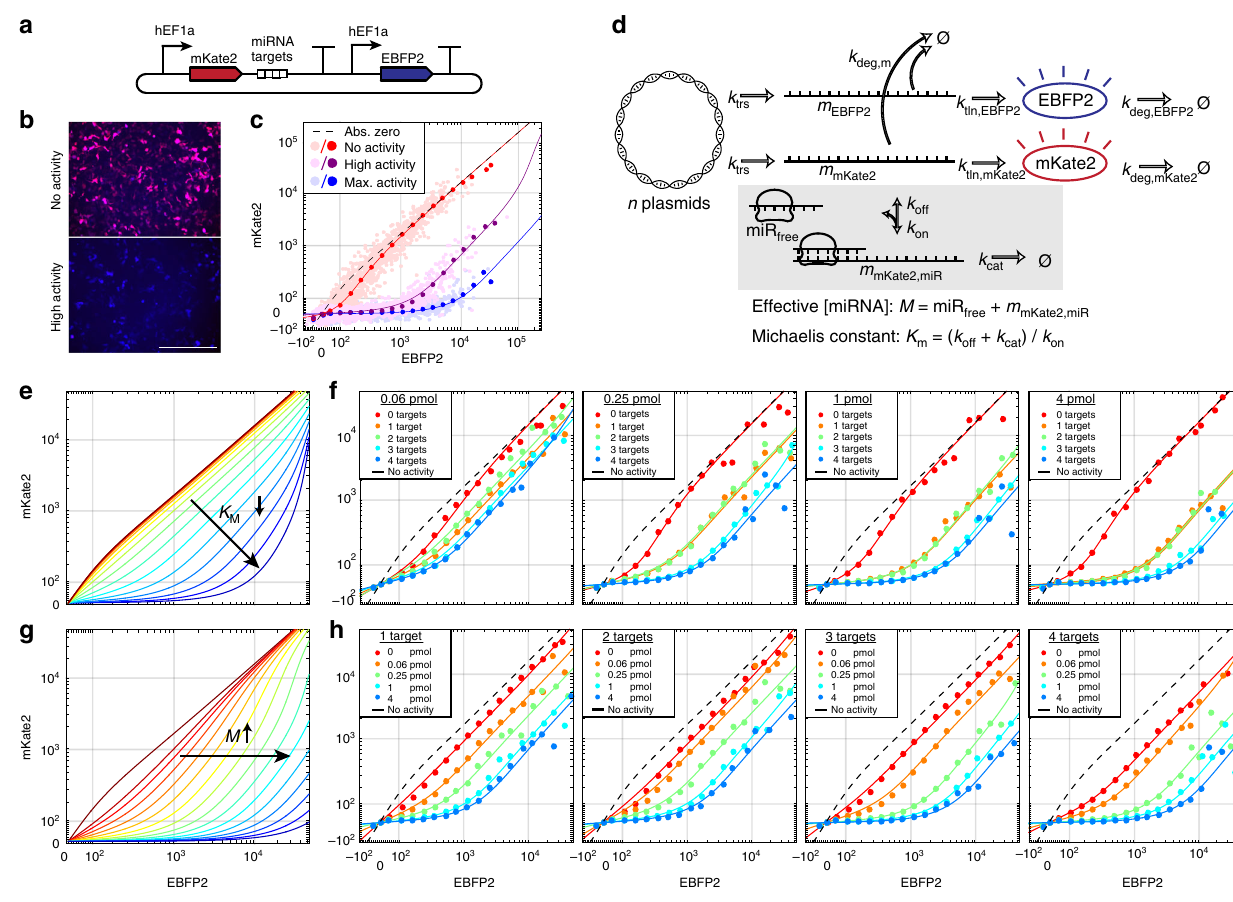
Fig. 1 A biochemical model explains miRNA repression measured using miRNA sensors. a A schematic of the single-input miRNA low sensors used in this study. b Fluorescence microscopy in HEK293FT cells for a control sensor with miRNA target sites with no activity (FF4) compared to a sensor with target sites for a high activity miRNA (miR-106a-3p). Both images are merged blue/red channels and the scale bar indicates 400 μ m. c Corresponding fl ow cytometry data in HEK293FT cells for no activity (red) and high activity (purple) sensors. Data for a positive control using exogenous siRNA to repress mKate2 is shown for reference (blue). Light scatter points correspond to data; dark points represent median values for data binned by EBFP2 fl uorescence; lines indicate fi ts to the data using a biochemical model; dashed line shows modeling results with absolutely zero miRNA activity. Fluorescence is shown in terms of arbitrary units and with logicle scaling for the axes 46 . d The single-input repression model annotated with relevant species and rate constants. Each cell is transfected with some number of plasmids ( N ) which are transcribed (at rate k trs ) and translated ( k tln,EBFP2 and k tln,mKate2 ) to yield fl uorescent proteins. mKate2 transcripts are reversibly bound by a miRNA-containing complex ( miR free ) forming a bound species ( m mKate2,miR ) which is catalytically degraded at some rate ( k cat ). Two parameters, effective miRNA concentration ( M ) and Michaelis constant ( K m ) fully characterize miRNA activity. RNA and protein species are non-speci fi cally degraded at some rate. Fixed rate constants are approximated from literature values (Supplementary Table 3). e Model predictions for decreasing K m while holding M constant. As K m decreases, repression increases while switching threshold is maintained. f Experimental perturbation of K m . HEK293FT cells, which exhibit low endogenous miR-21-5p activity, were transfected with sensors containing varying numbers of target sites for miR-21-5p and varying amounts of exogenous miR-21-5p mimic. As the number of target sites was increased (decreasing K m ), repression increased as predicted. g Model predictions for increasing M while holding K m constant. As M increases, the switching threshold increases and repression increases as a result. h Experimental perturbation of M . As miR-21-5p mimic concentration is increased, repression increased as